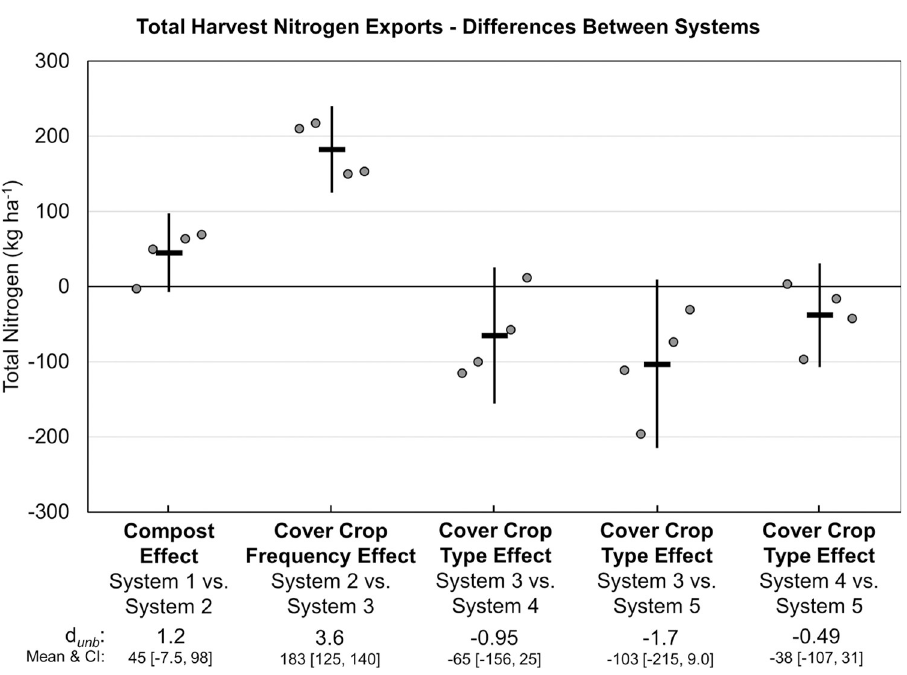
Fig 13. Mean paired difference in cumulative total harvest nitrogen exports between systems over eight years of vegetable production. Measurements were taken in five organic vegetable systems. Systems differed by annual compost additions, cover crop type and cover cropping frequency. System 1 = no compost+legume-rye 4 th year; System 2 = annual compost+legume-rye 4 th year; System 3 = annual compost+legume-rye annually; System 4 = annual compost+mustard annually; System 5 = annual compost+rye annually. Error bars are 95% confidence intervals (CI) around the mean (horizontal line). Data points are replicates 1 through 4 averaged across years and are clustered around the mean left to right so as not to obscure the mean and CI. The standardized effect size (Cohen’s unbiased d , d unb ) is shown below the